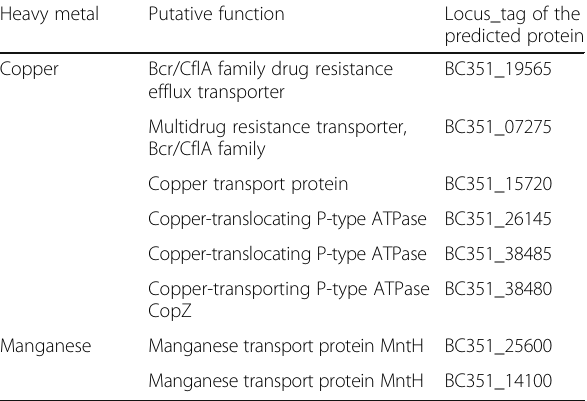
Table 6 Putative proteins involved in metal(loid) resistance